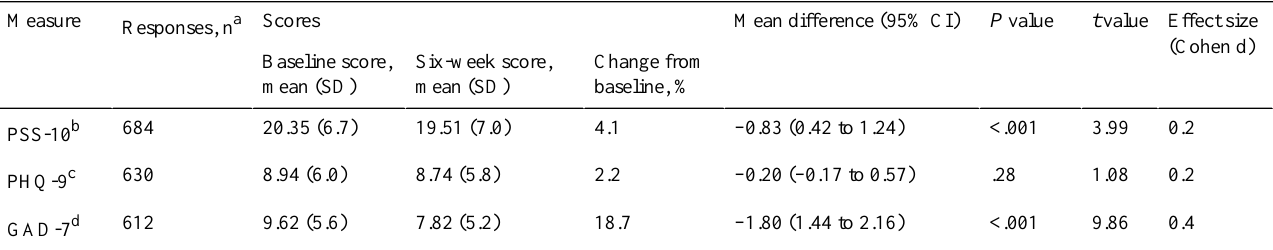
Table 2. Comparison of the baseline and 6-week mean scores on the PSS-10, GAD-7, and PHQ-9 scales for subscribers who completed both the baseline and sixth week surveys (N=766).